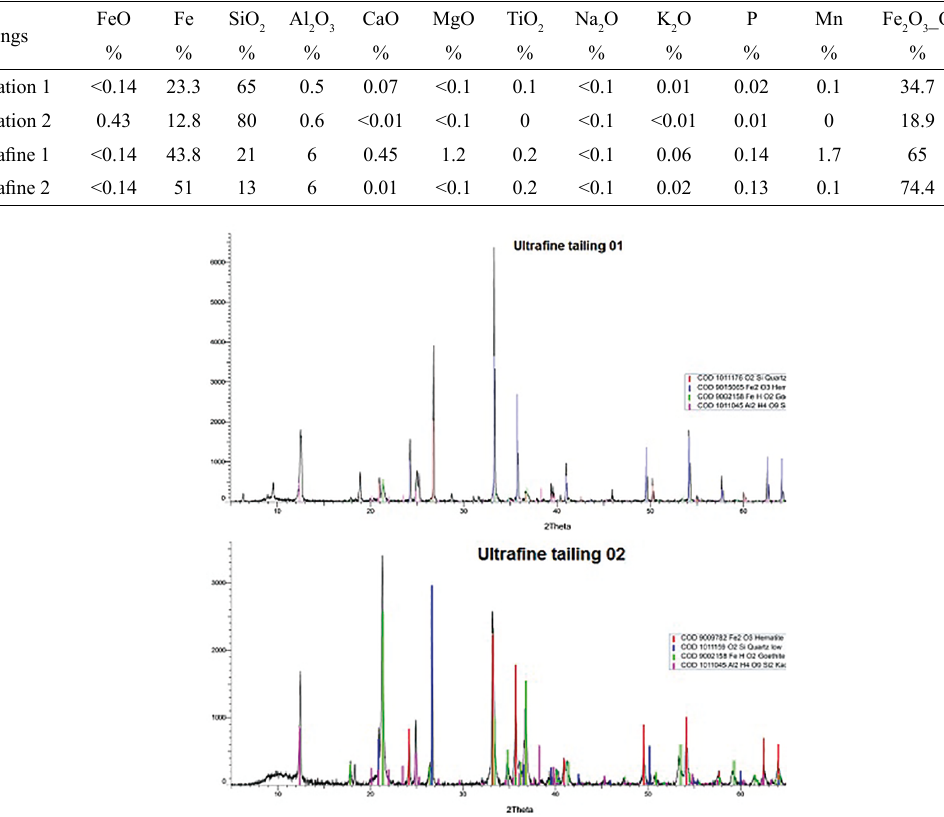
Table 1. Mean chemical analysis of tailings by X-ray fluorescence.